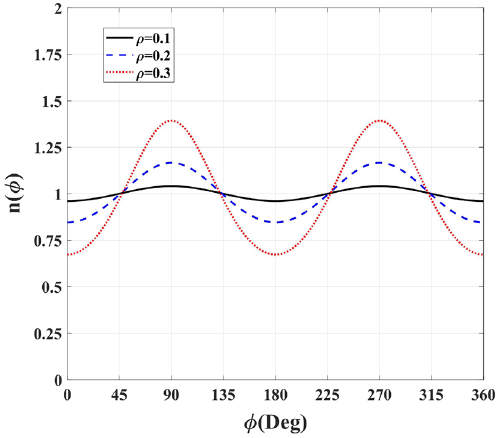
Figure 15. The refractive index of the physical space’s outer contour versus φ for ρ = 0.1, 0.2 , and 0.3 m.